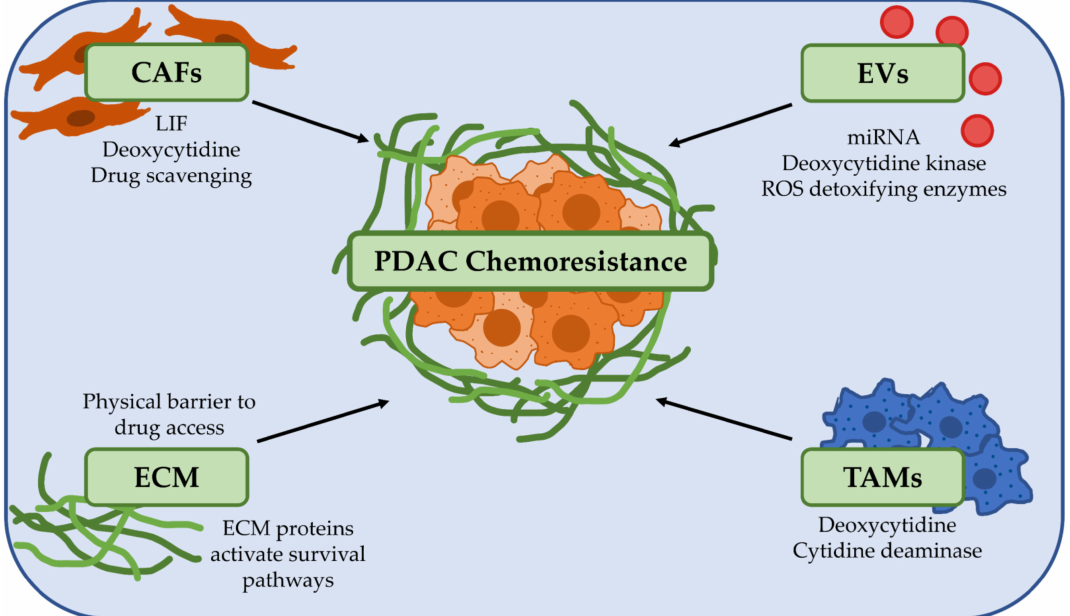
Figure 1. The tumour microenvironment is a key player in promoting chemoresistance in pancreatic ductal adenocarcinoma (PDAC). PDAC chemoresistance can be influenced by a broad range of factors in the tumour microenvironment. Cancer- associated fibroblasts (CAFs) secrete factors such as leukaemia inhibitory factor (LIF) and deoxycytidine which directly promote drug resistance and can also metabolise and inactivate drugs such as gemcitabine. Extracellular vesicles (EVs) and tumour associated macrophages (TAMs) can also secrete different factors to drive chemoresistance in PDAC cells. The extracellular matrix (ECM) can be a physical barrier to drug delivery by compressing blood vessels, and proteins that make up the ECM such as collagen, laminin and hyaluronan can activate survival pathways in PDAC cells to